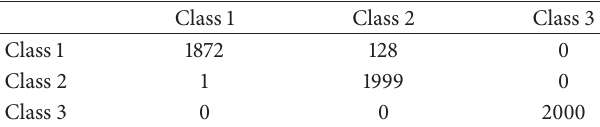
Table 2: Confusion matrix of